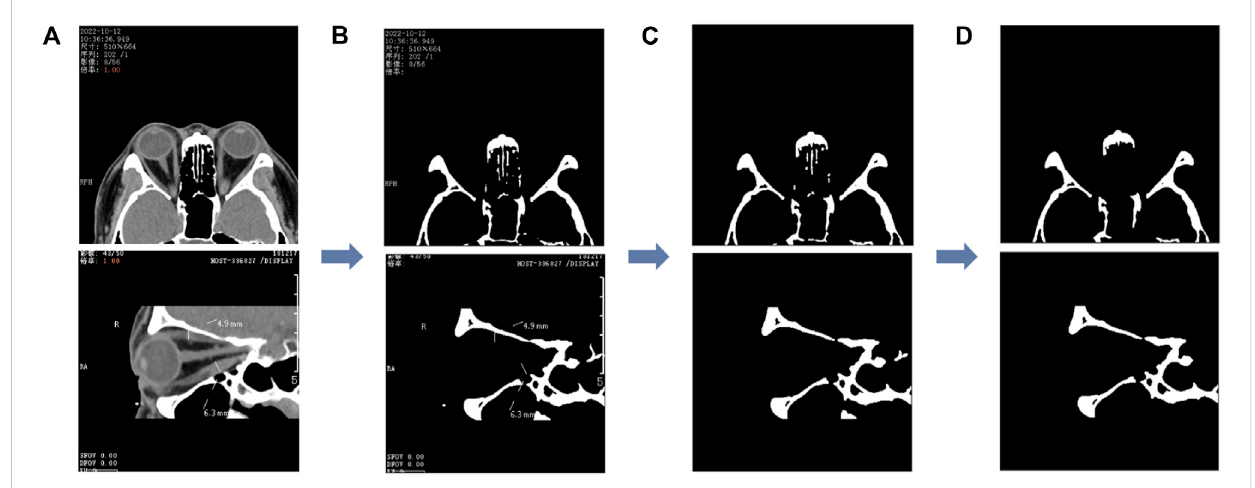
FIGURE 3 Image processing of the segmented orbital rim region. (A) The unprocessed CT image and the binary image in (B) are obtained after the threshold segmentation; the binary image shown in (C) is obtained after the morphological opening operation, and fi nally, the smaller connected domain is eliminated toobtainthebinaryimagecontainingtheouteredge oftheorbitshownin (D) . The fi rstrowrepresents theaxialCTimageandthesecondrow the sagittal CT